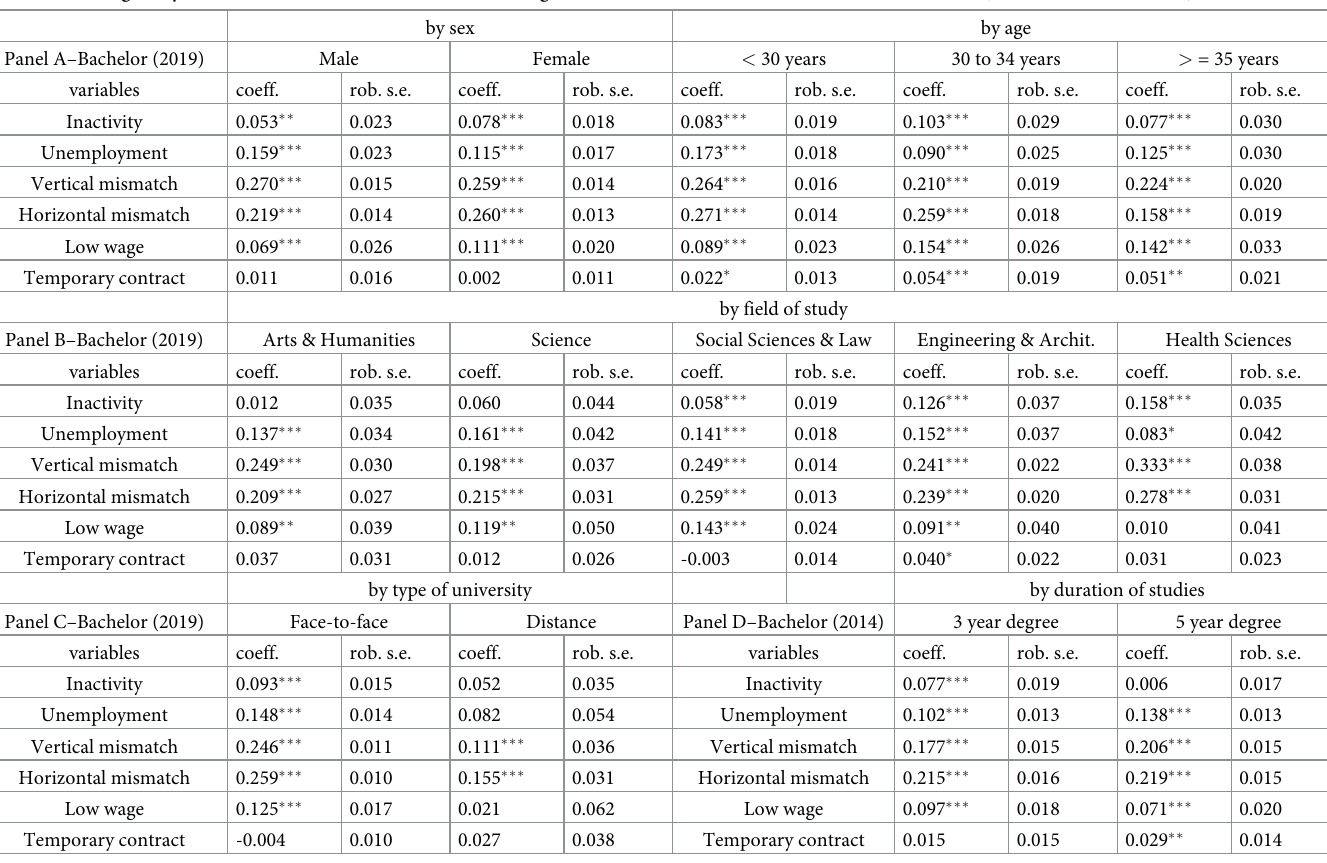
Table 9. Heterogeneity in the estimates of the association between graduate labour market outcomes and dissatisfaction (Bachelor 2019 and 2014). by sex by